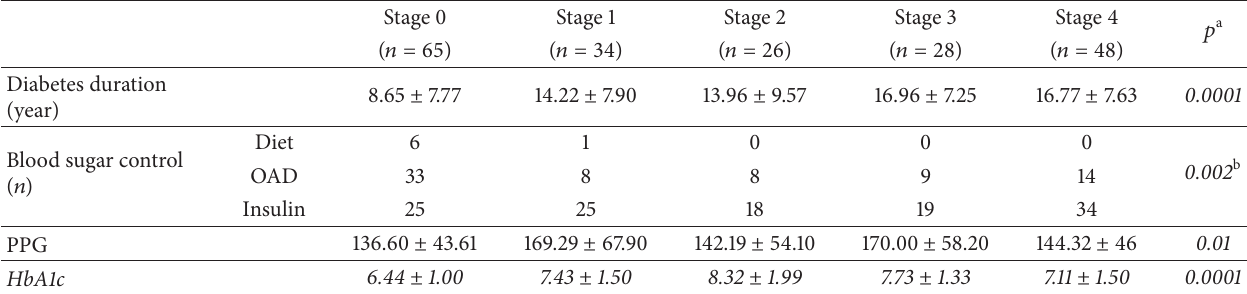
Table 3: Clinical characteristics of patients in relation to diabetes according to stages.